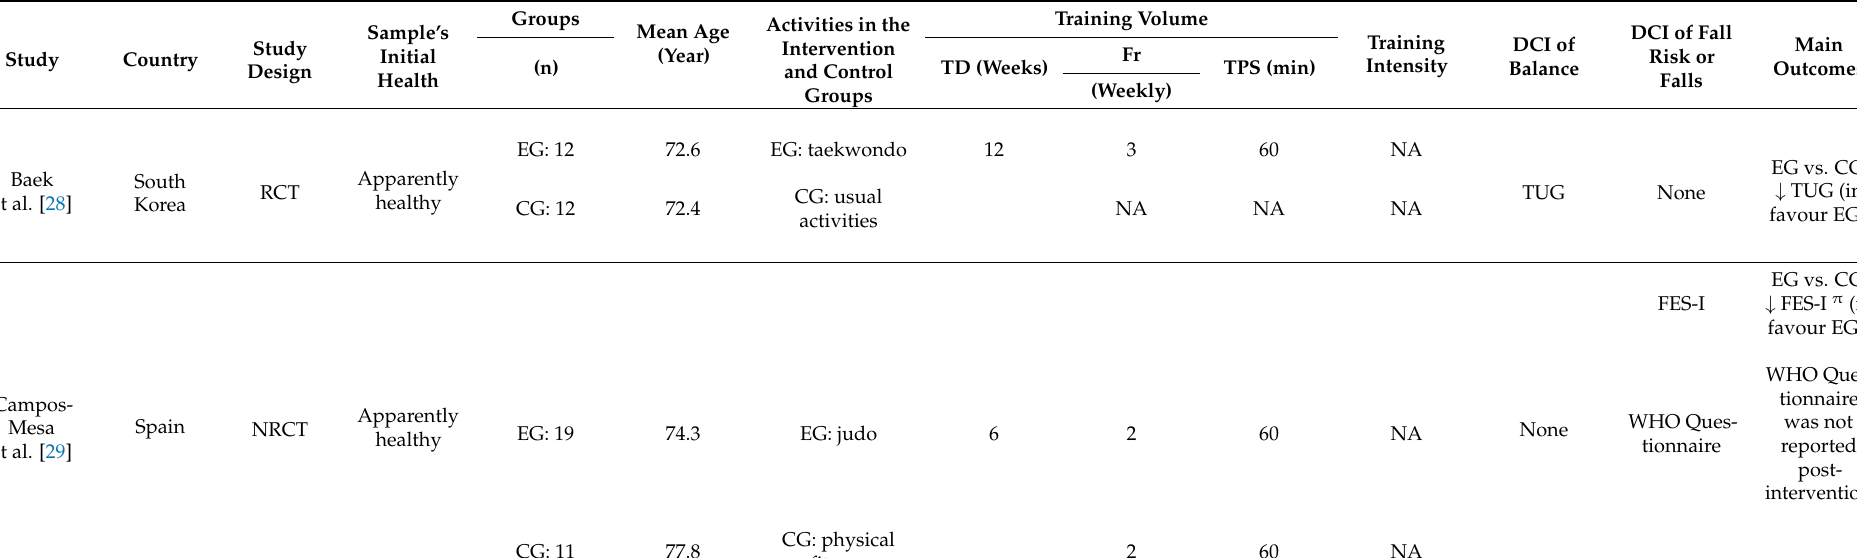
Table 4. Studies reporting on the effectiveness of Olympic combat sports on balance, fall risk, or falls in older